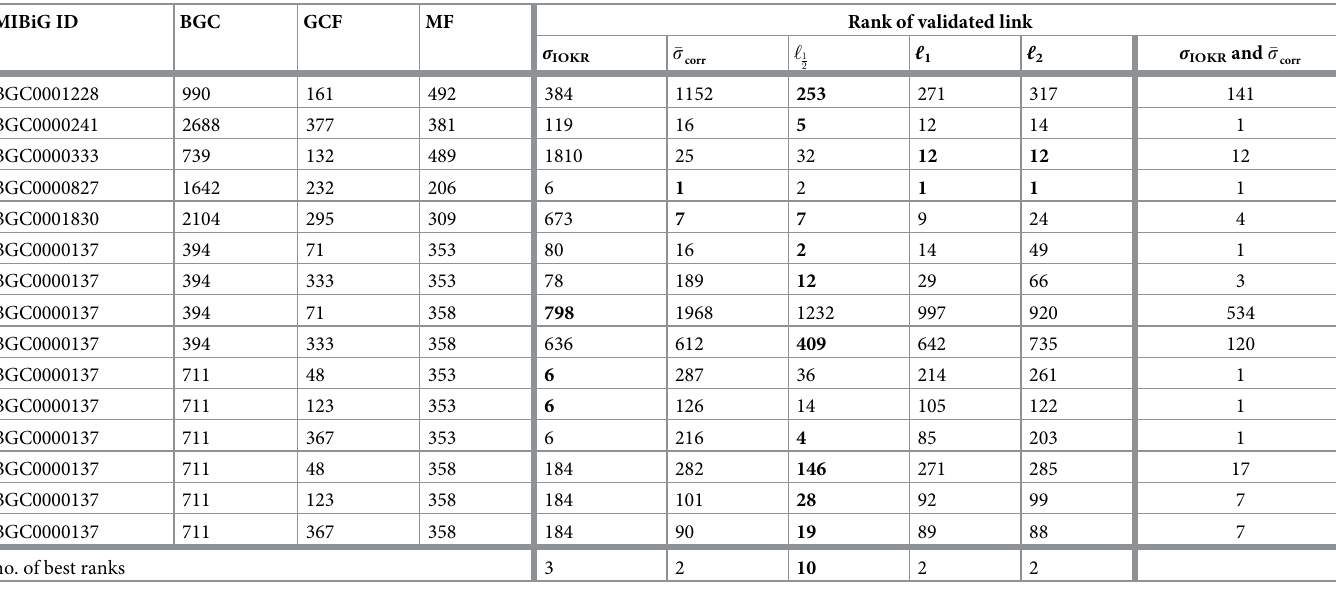
Table 4. Scoring function